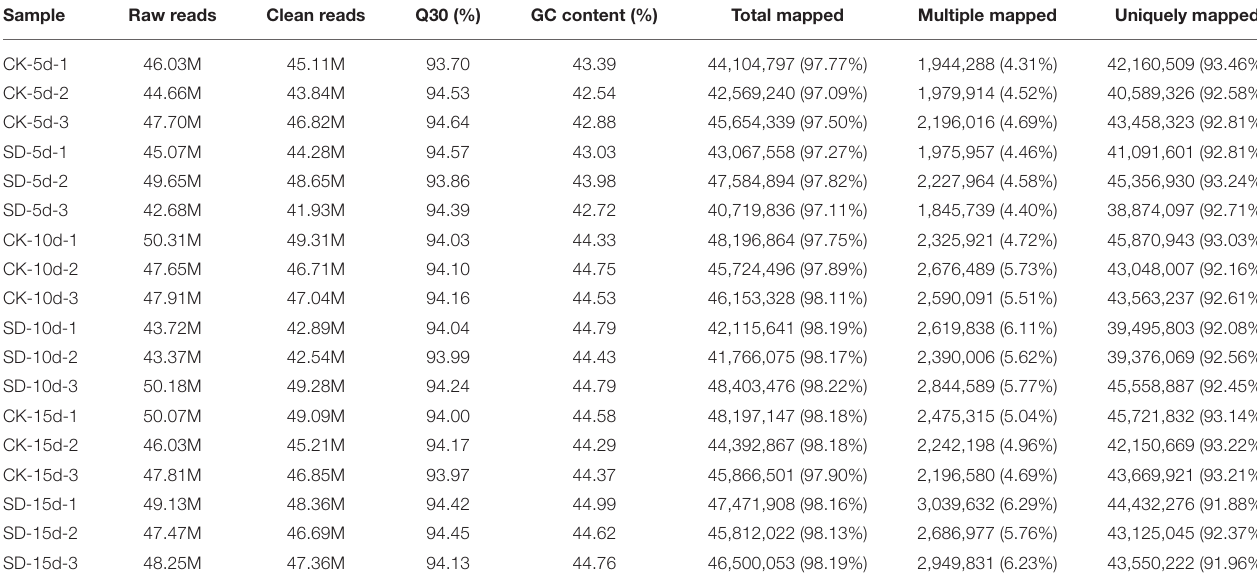
TABLE 4 | Summary of RNA-seq results.